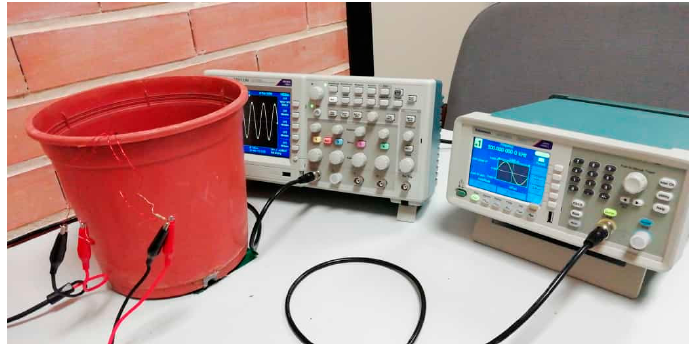
Figure 5. Assembly for the first set of tests.